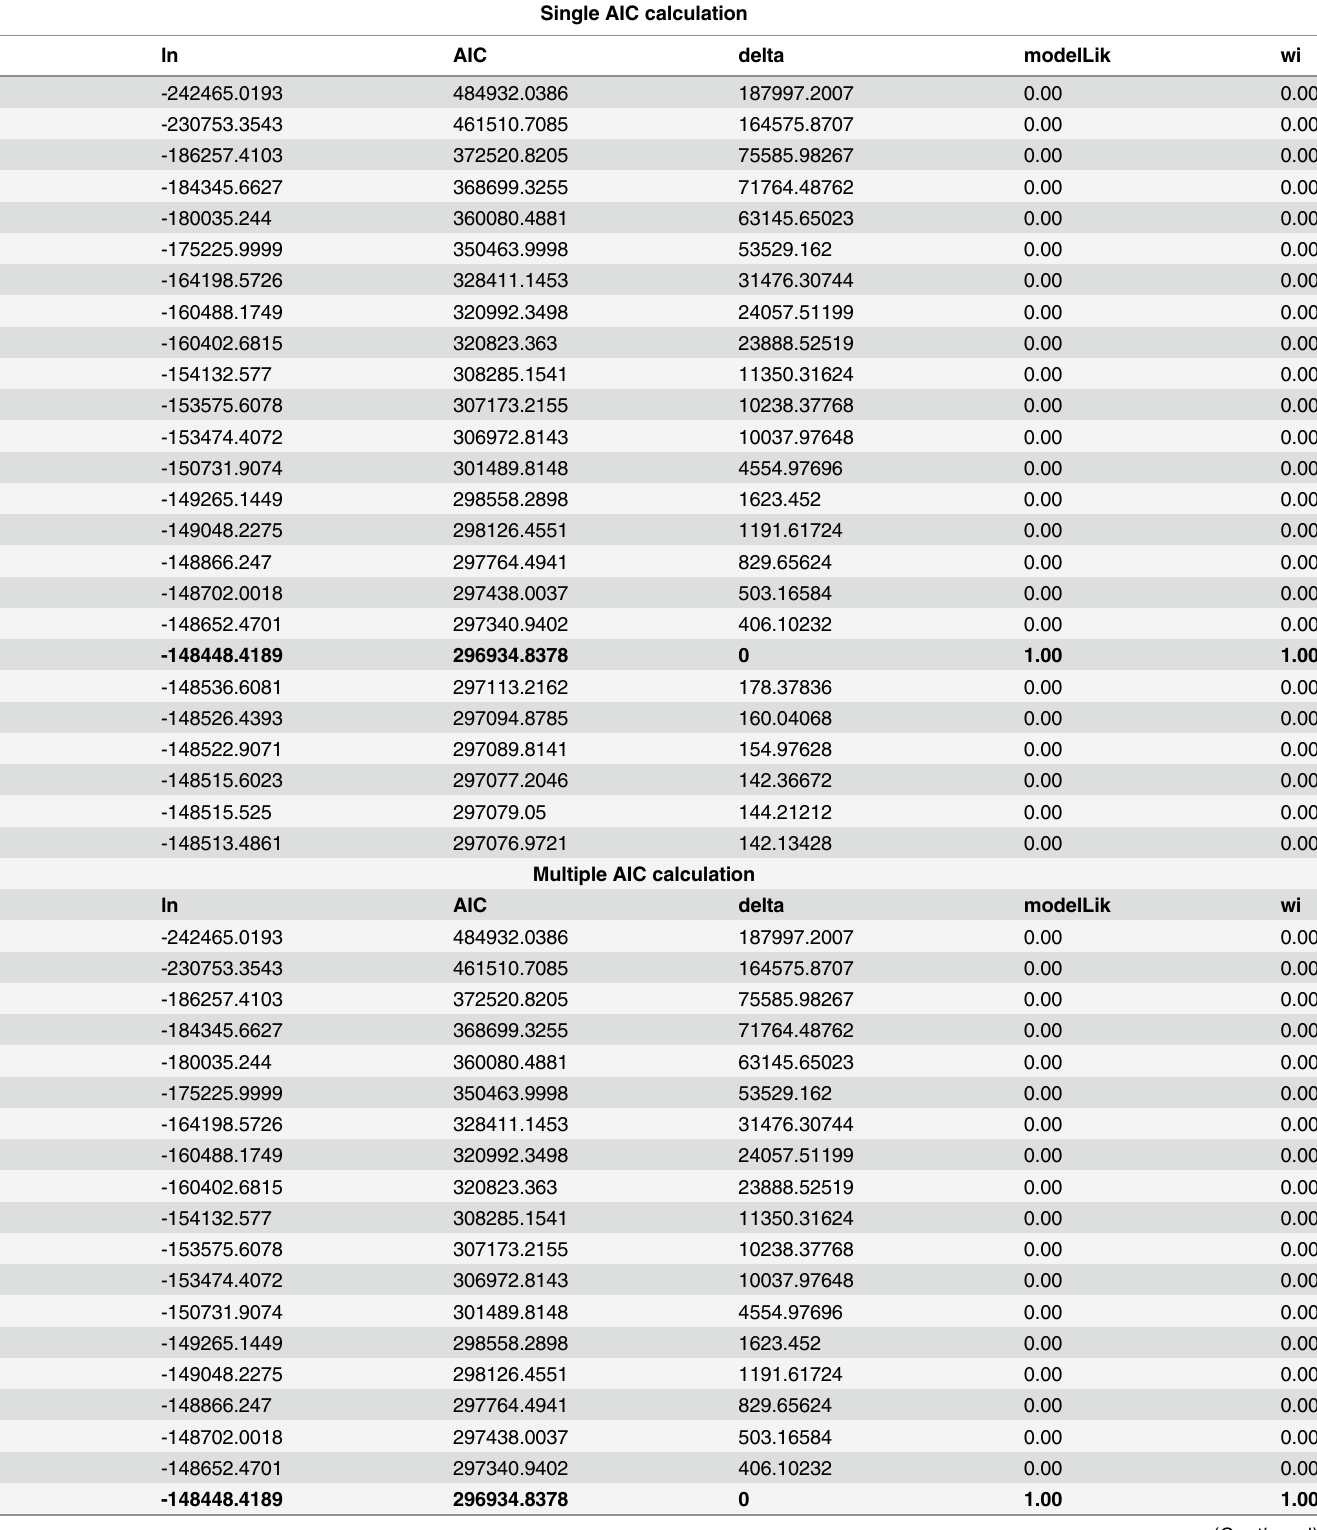
Table 3. SpedeSTEM validation